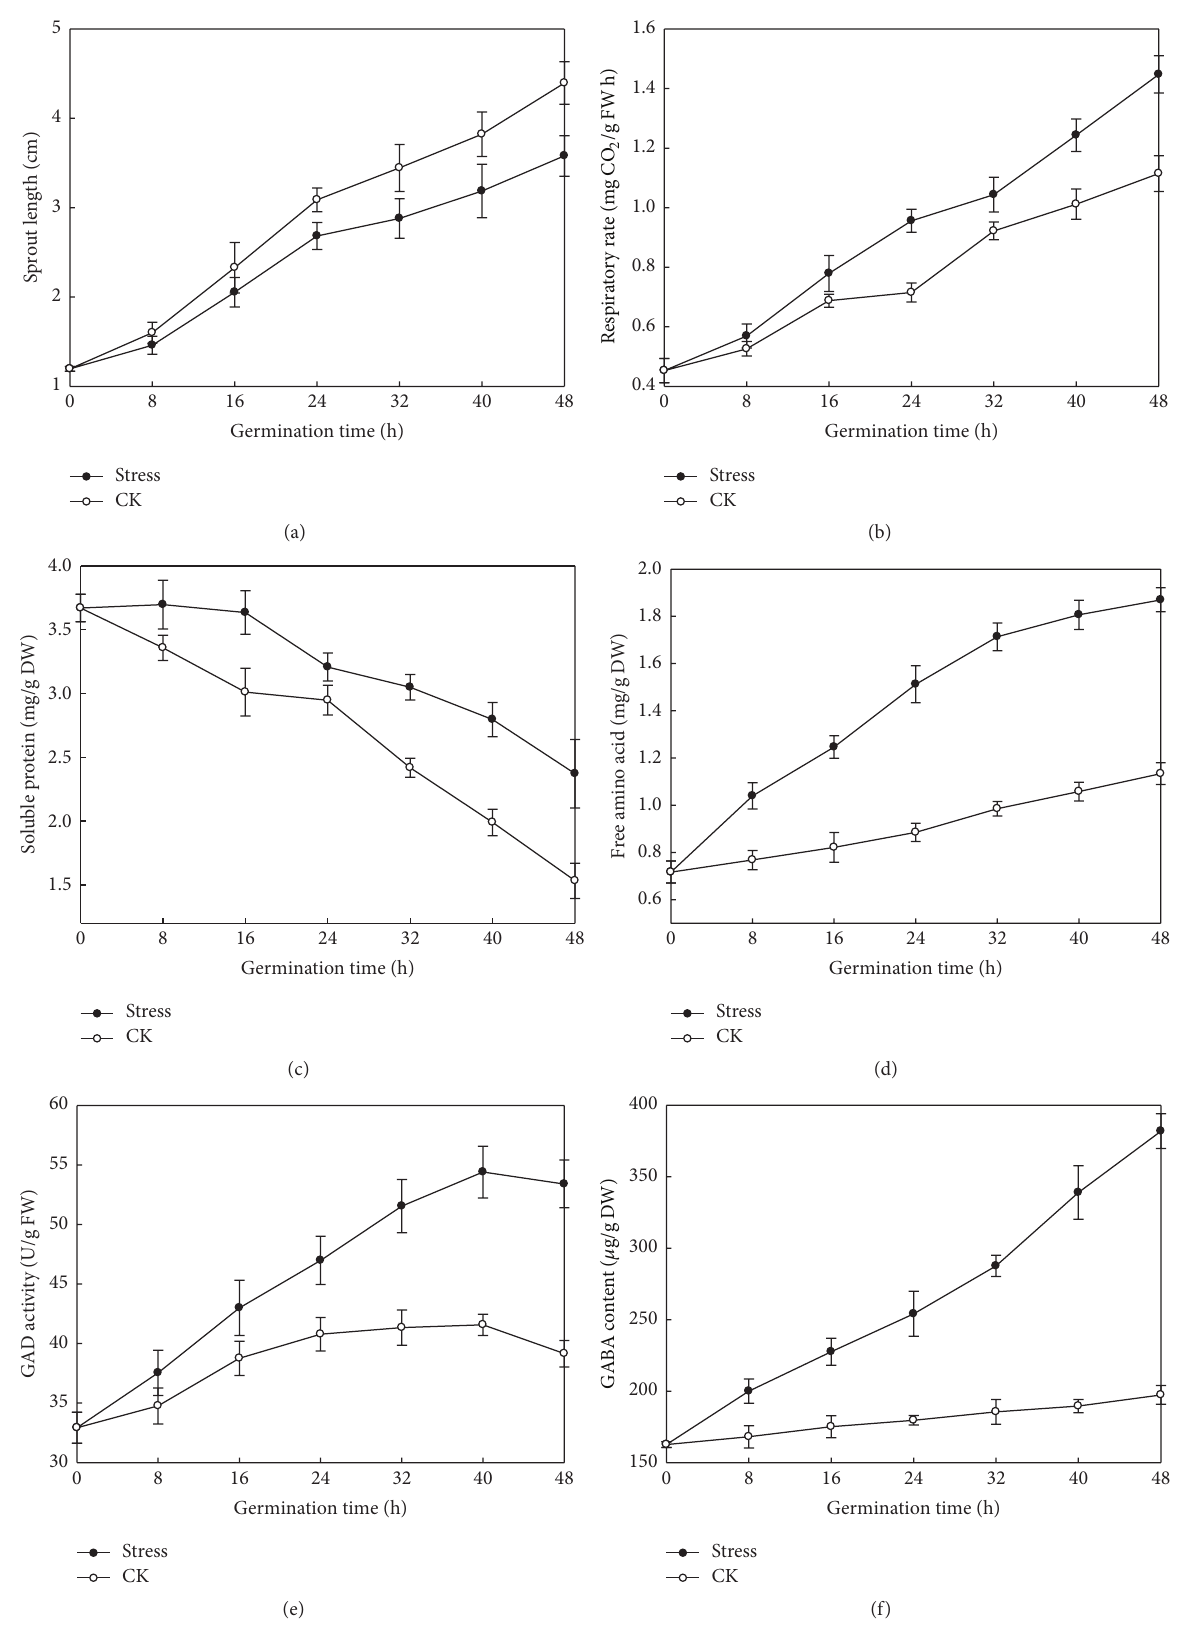
Figure 2: Effects of germination time on the physiological indexes of tartary